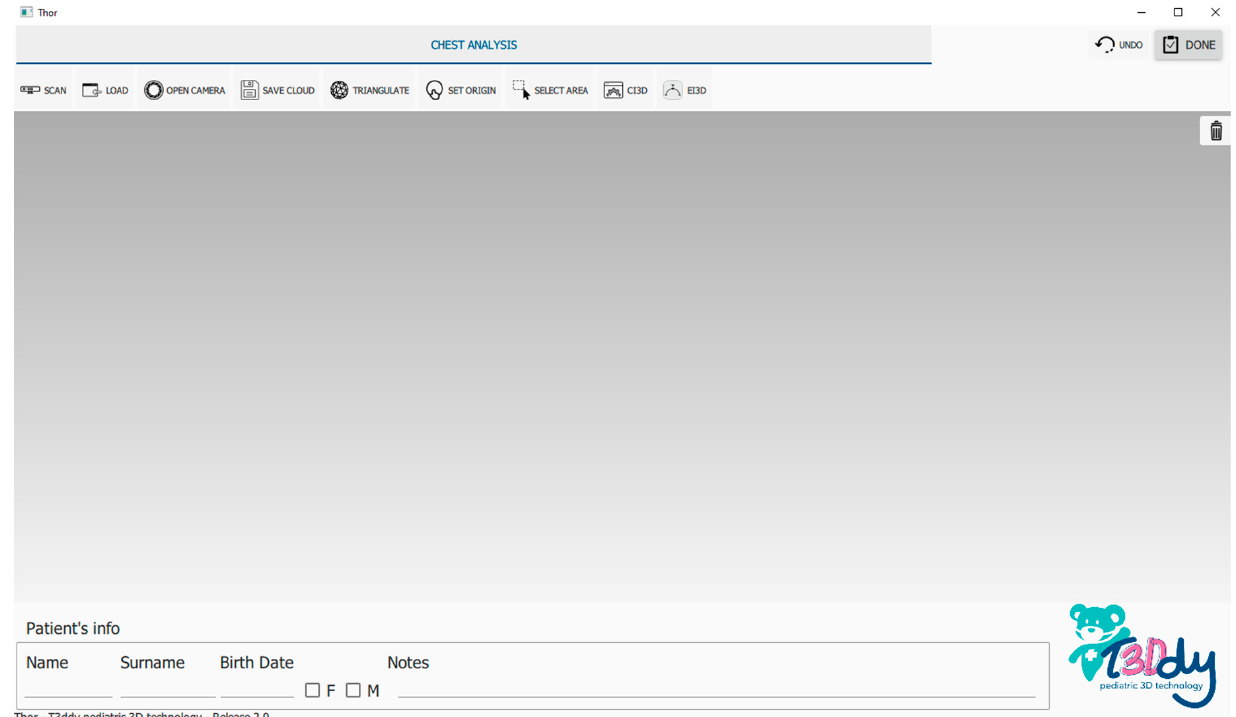
Figure 4. New graphical user interface for the 3D digital model of the frontal chest